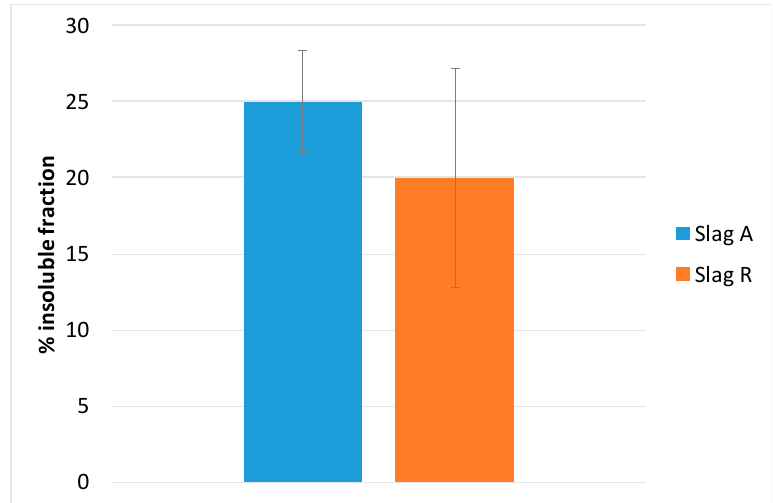
Figure 5. Insoluble fraction after HCl test of Slag A and Slag R.